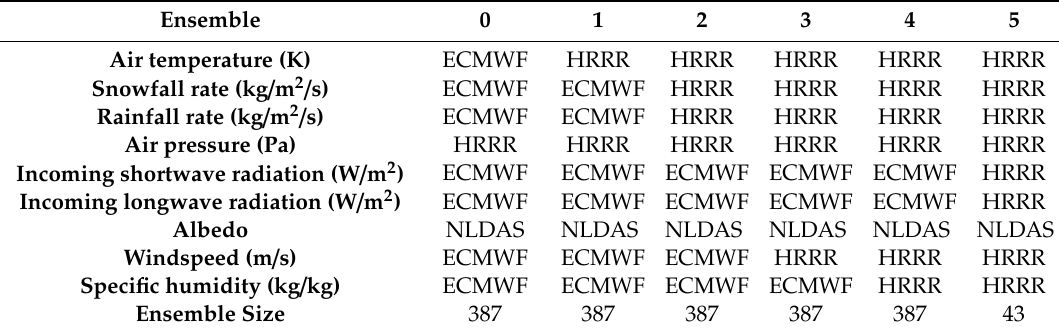
Table 1. Summary description of ensemble forecast family 1 (EFF1) design. Grand Mesa ensembles are produced using 9 ECMWF and 43 HRRR distinct forcing time-series. Data are available at https: // barros-group.cee.duke.edu /